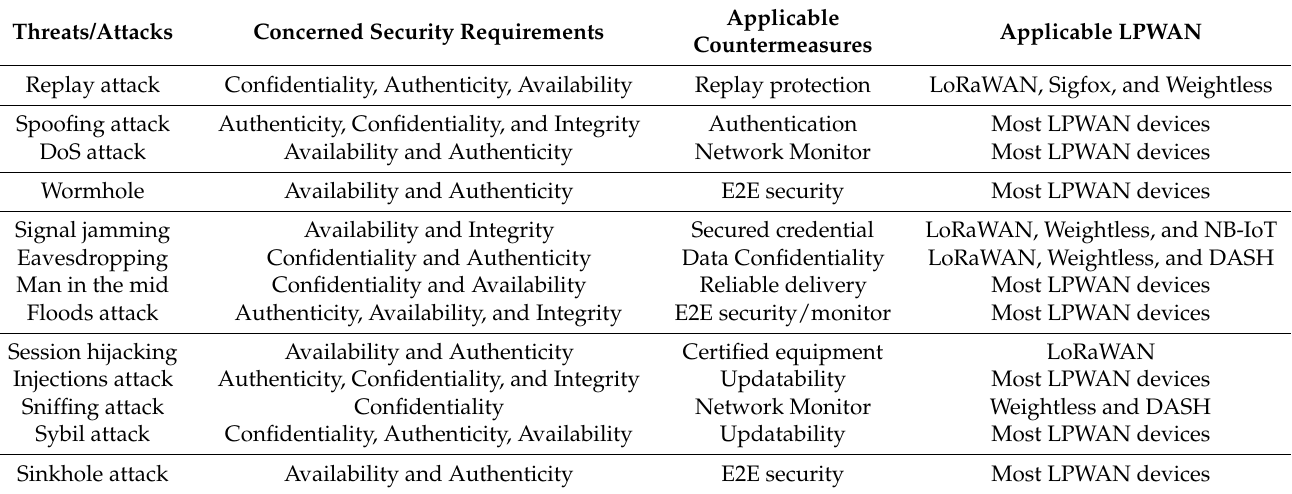
Table 5. Security threats and the applicable countermeasures in